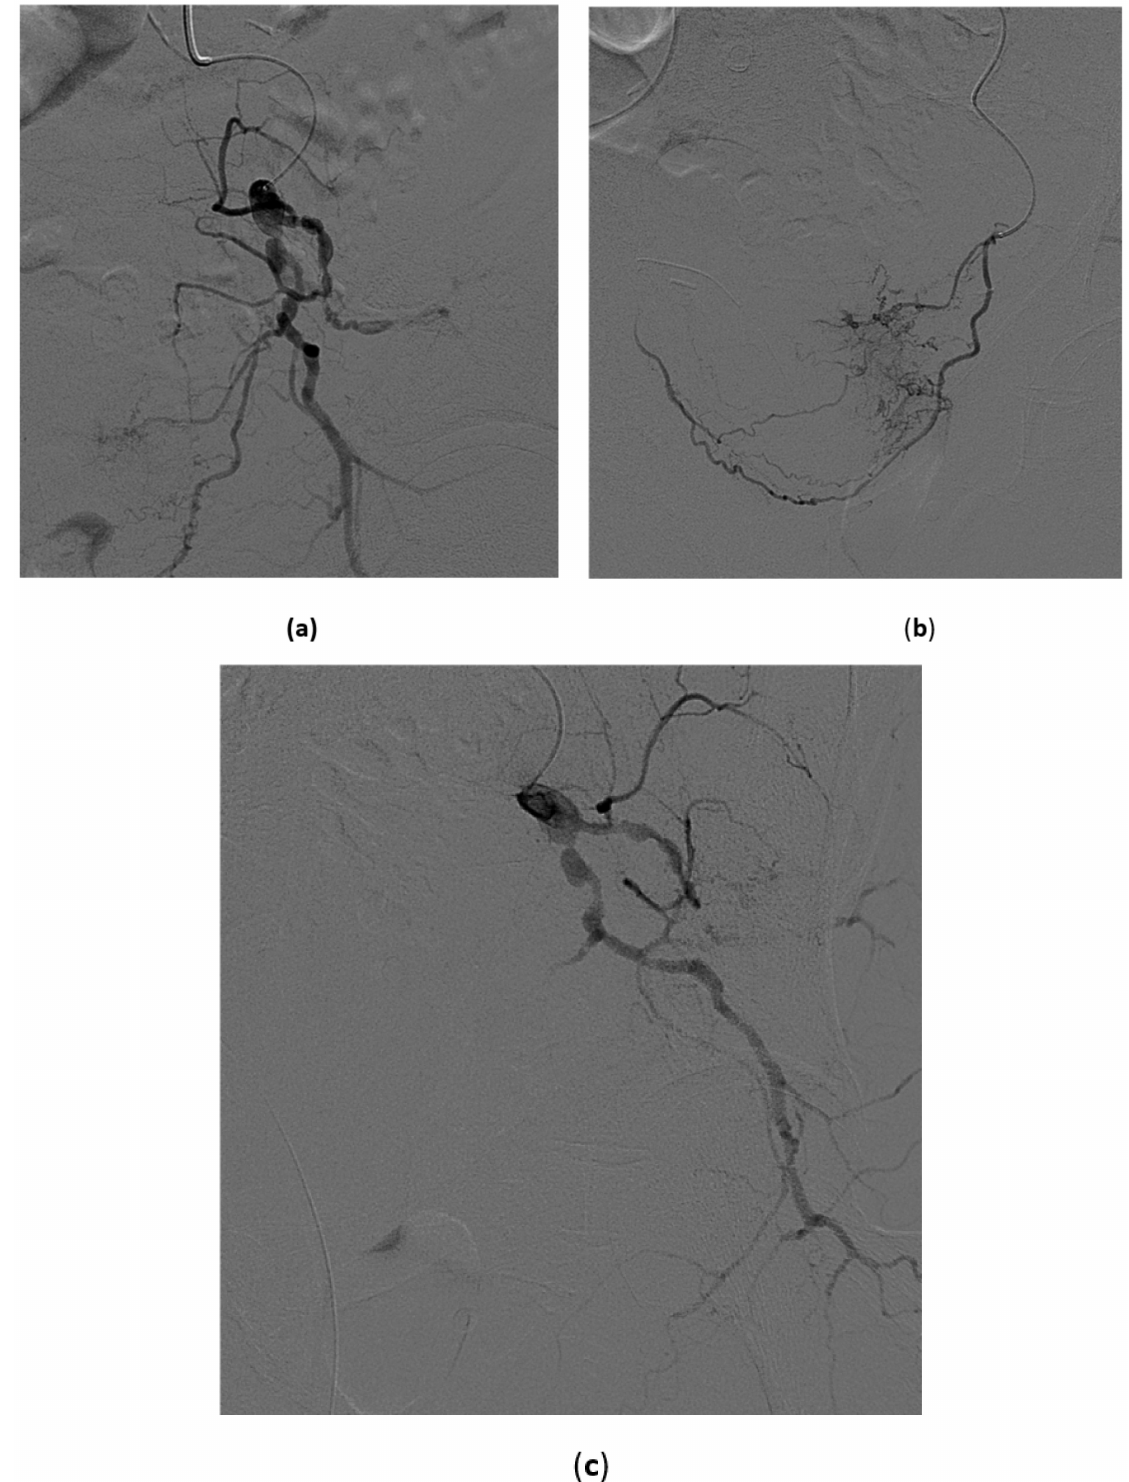
Figure 8. Superselective embolization of the vesical arteries. 104-year-old male, advanced bladder cancer with macroscopic hematuria. ( a ) The preliminary angiogram shows the vesical arteries originating as branches of the anterior division of the internal iliac artery. Diffuse atherosclerotic irregularities of the vessels are present; ( b ) Superselective catheterization of the vesical vessels is performed and an abnormal hypervascularity is demonstrated; ( c ) After embolization with 500–700 µ m particles, the final angiogram shows adequate occlusion of the vessels. The procedure was then repeated on the contralateral